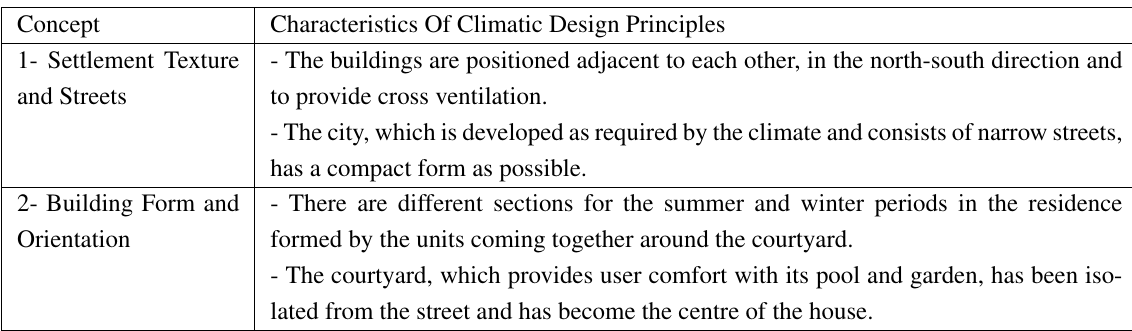
Table 1. Characteristics Of Traditional Gaziantep Houses’s Climatic Design